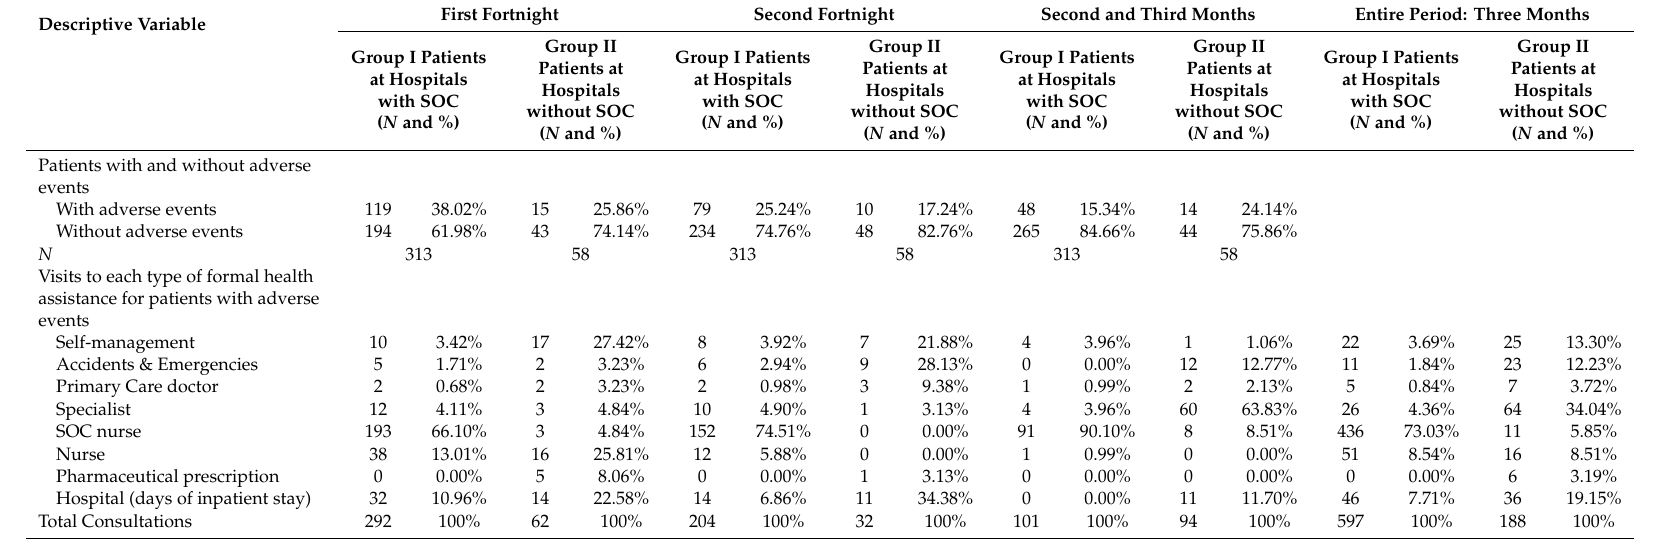
Table 2. Adverse events in stoma patients and demand of health services to solve